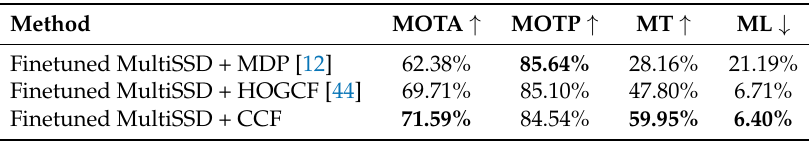
Table 3. Tracking results on the validation set with various trackers.